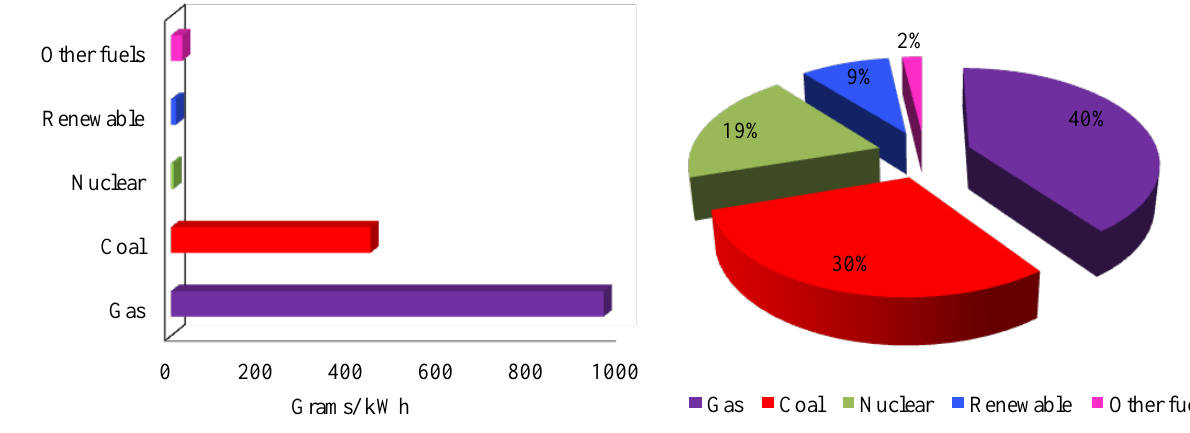
Figure 4. Fuels used in electricity production and associated CO